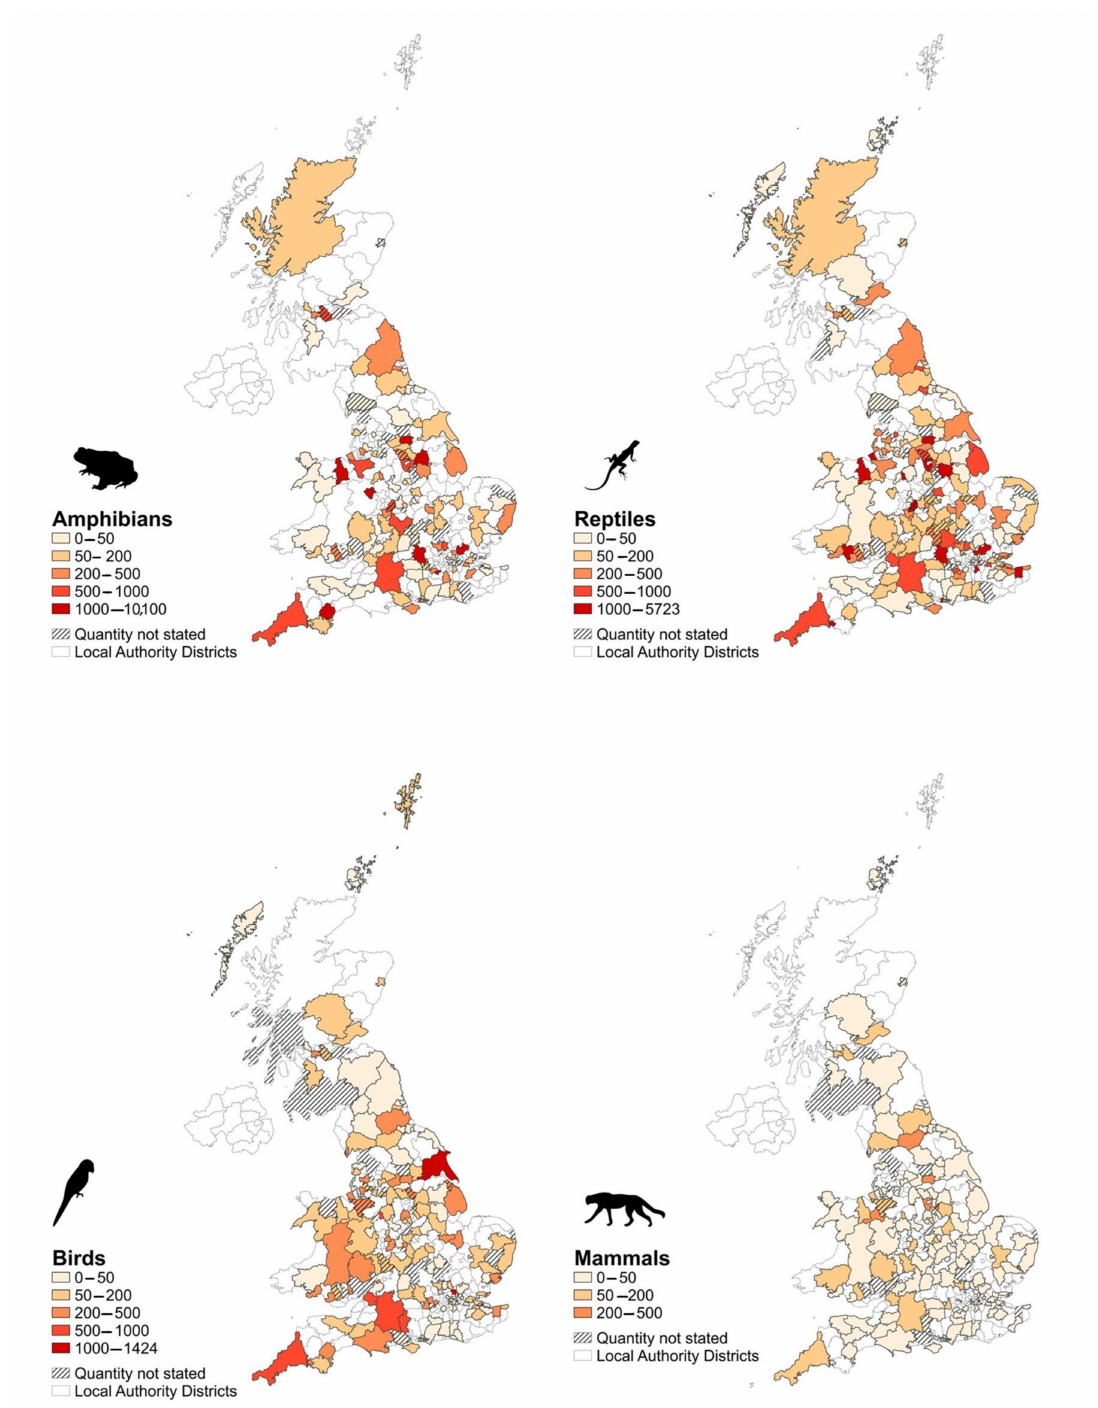
Figure 3. Potential maximum number of amphibians, reptiles, birds and mammals permitted for sale by UK Local Authority area, excluding Northern